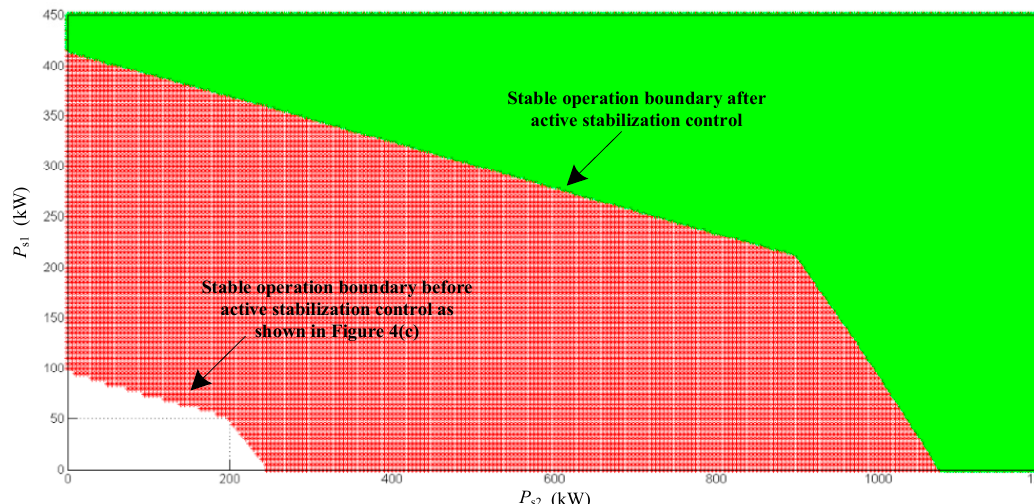
Figure 7. Stable operation boundary of slave VSC1 and slave VSC2 when P dc = 30 kW after active stabilization control.